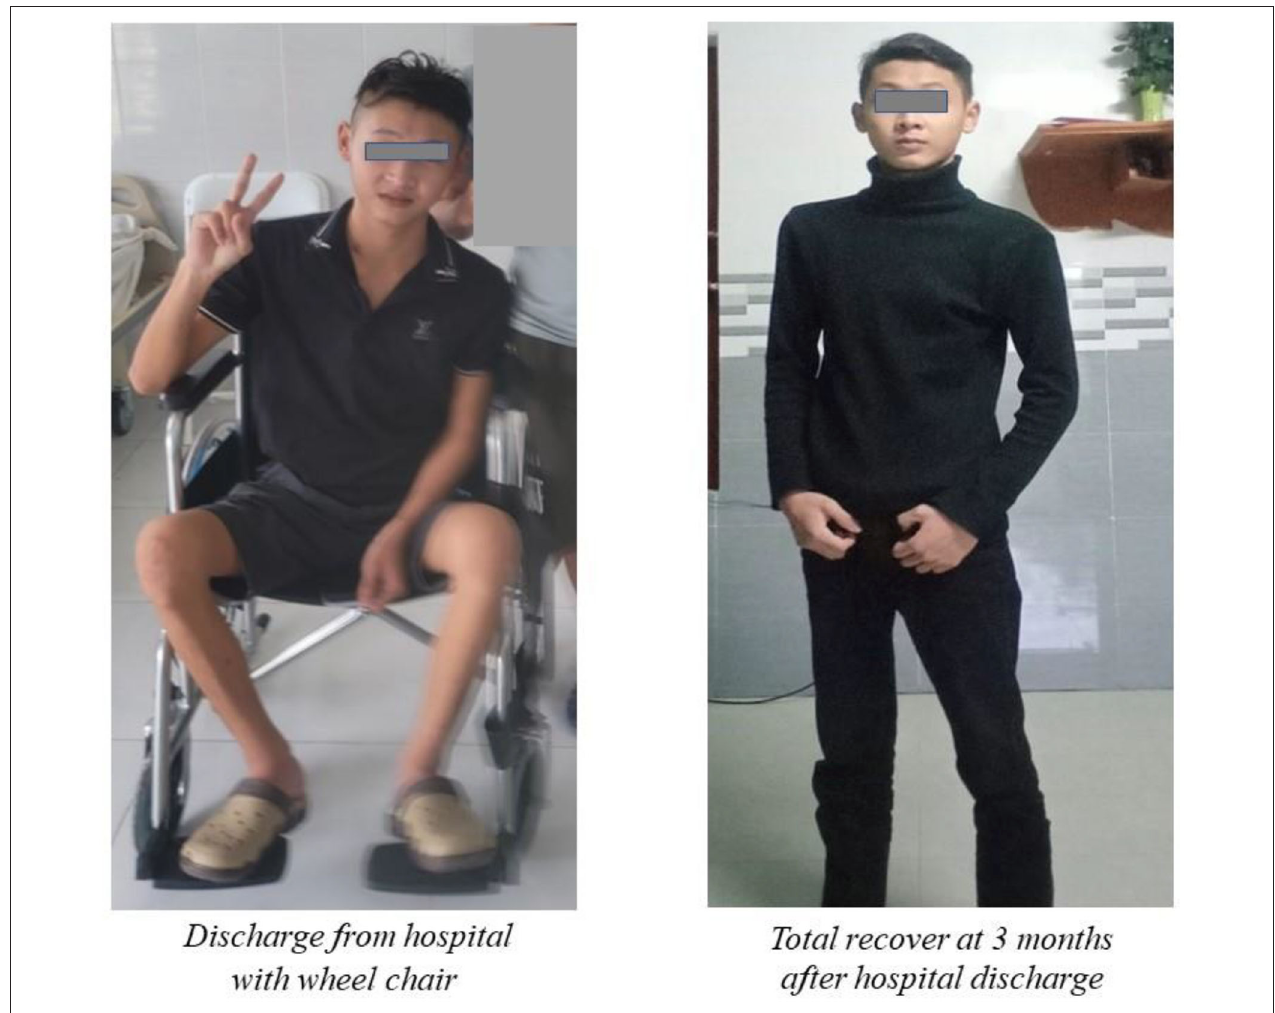
FIGURE 2 | Clinical status of reported patient at post-COVID